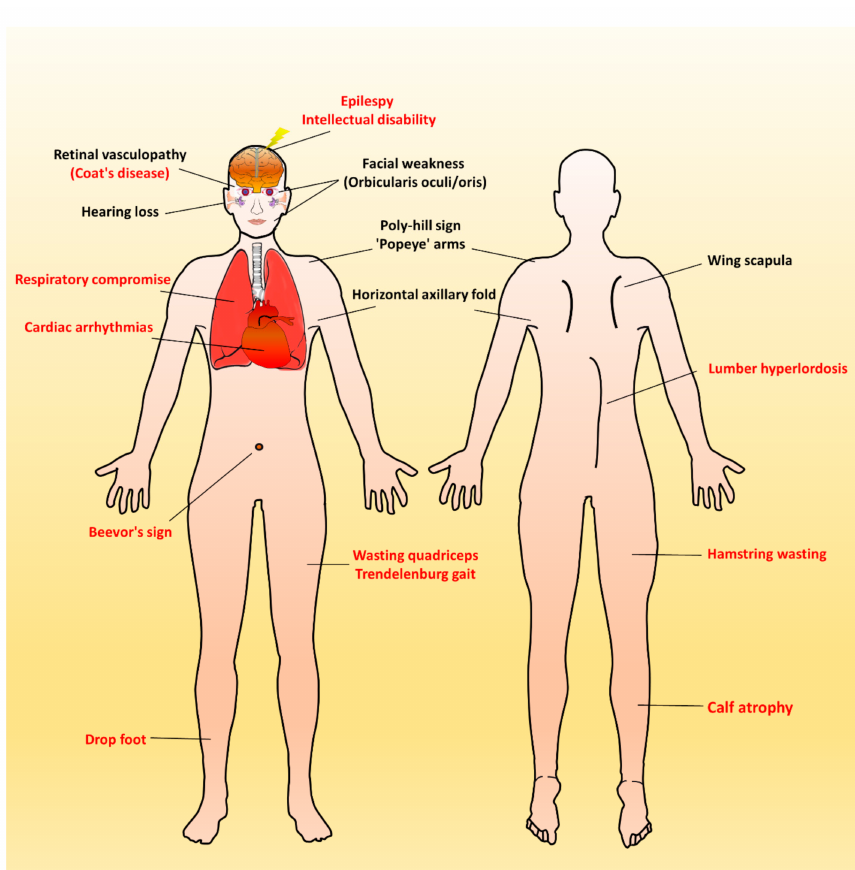
Figure 2. Characteristic muscular and extramuscular signs of FSHD. Generally, most patients with FSHD have multiple distinctive features (as listed in Table 1). Illustrated FSHD-related signs and symptoms marked with red text indicate atypical and relatively rare features that are usually presented in infantile FSHD or at the advanced stage of disease course. Figure modified from Mul et al. 2016